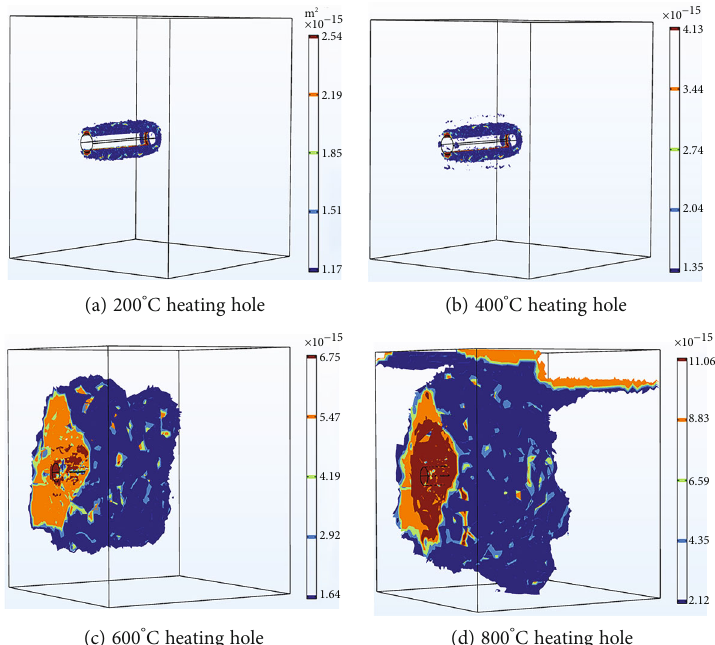
Figure 5: Isosurface map of coal permeability at di ff erent heating temperatures.